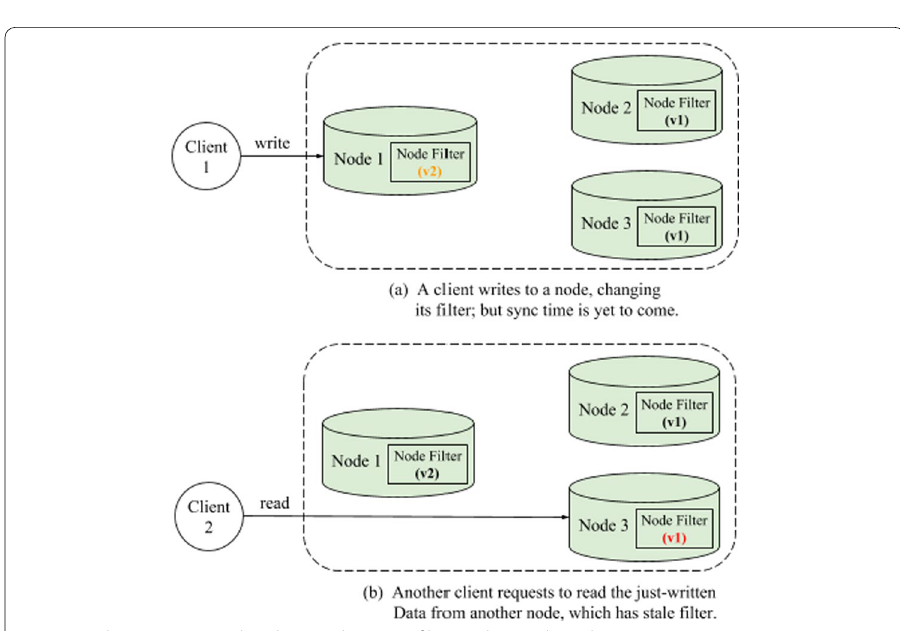
Fig. 22 False-negatives within the time between filter update and